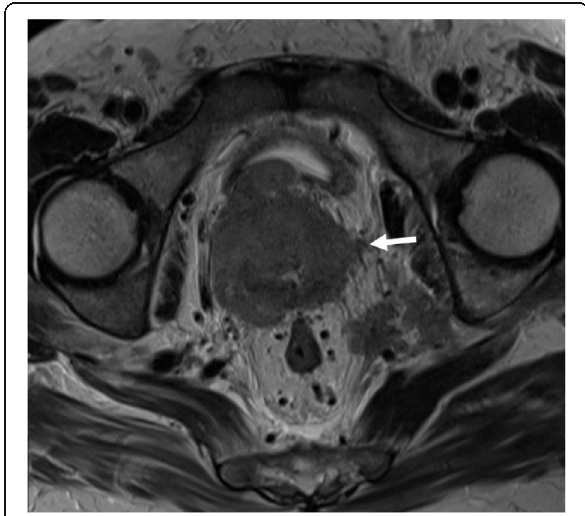
Fig. 3 Axial T2W MRI showed tumor involving right levator ani muscles (pelvic side wall invasion)